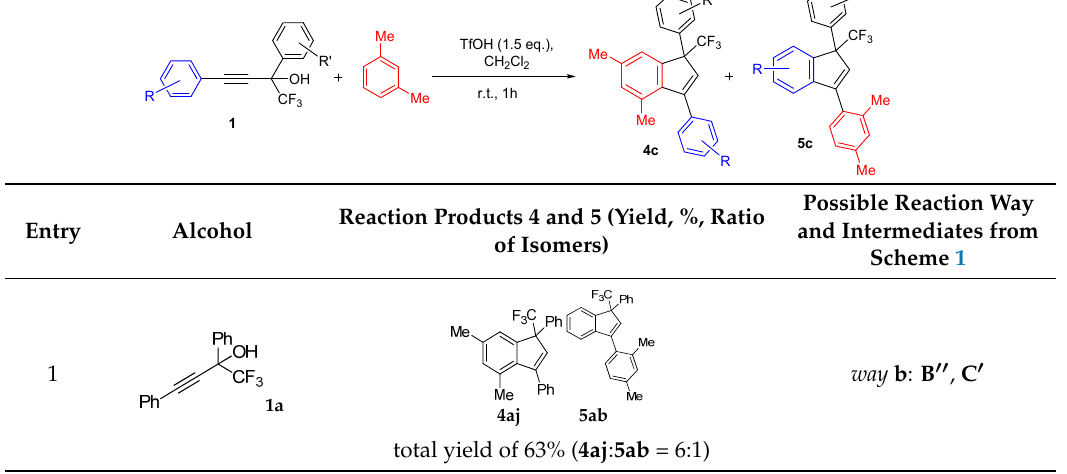
Reaction Products 4 and 5(Yield, %, Ratio of Isomers)